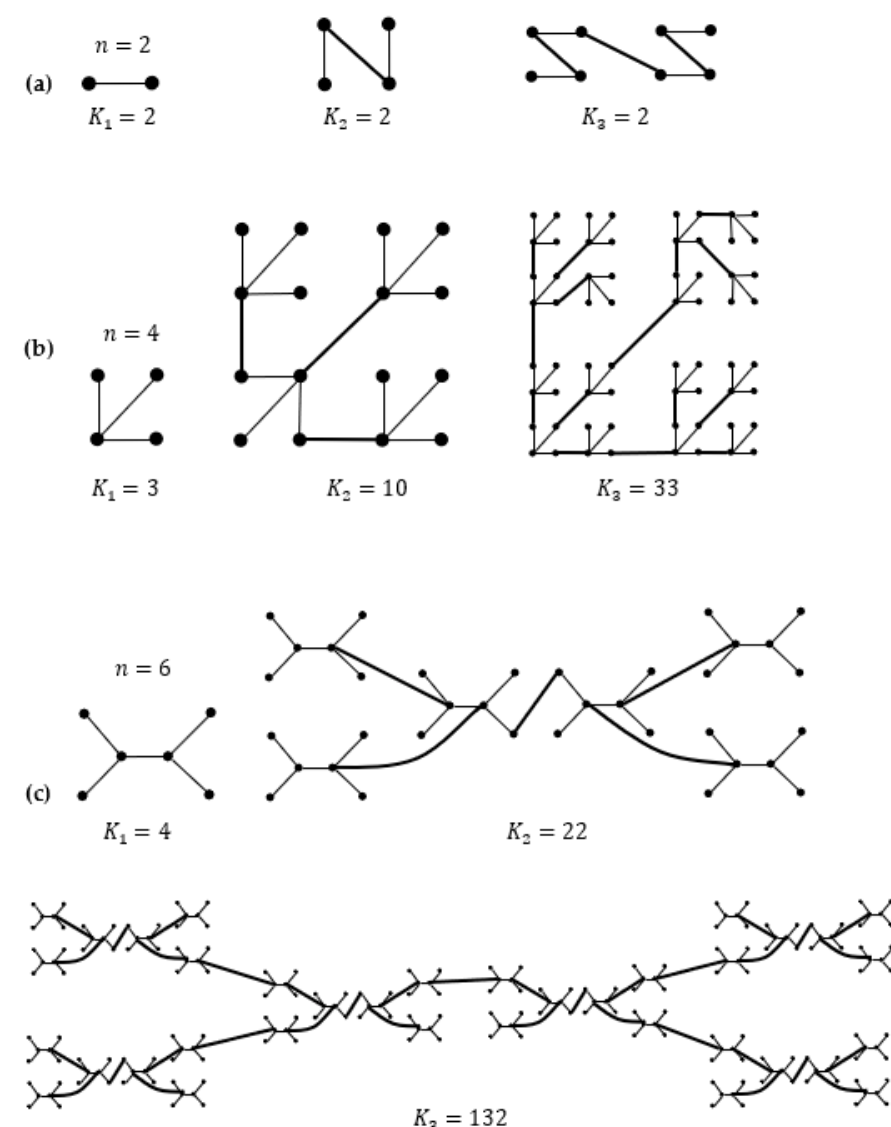
Figure 7. Spanning trees of prefractal graphs G 1 , G 2 , G 3 with leaf